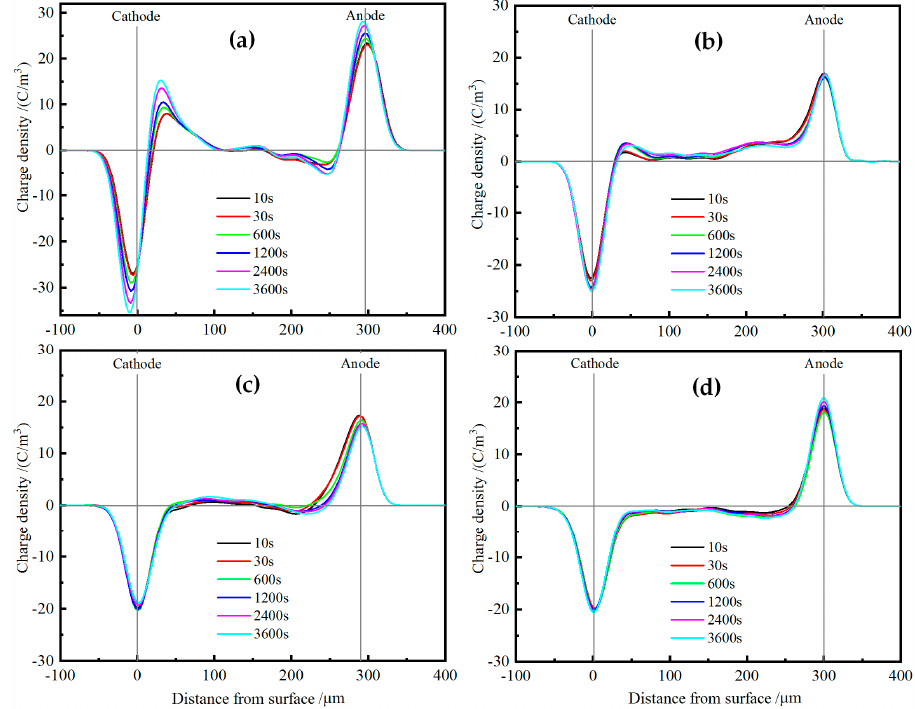
Figure 9. Space charge distributions in ( a ) pure XLPE and the nanocomposites of ( b ) 0.5wt%TAIC- s -SiO 2 / XLPE, ( c ) 1.5wt%TAIC- s -SiO 2 / XLPE and ( d ) 2.0wt%TAIC- s -SiO 2 / XLPE under DC electric field of 40 kV / mm at 40 ◦